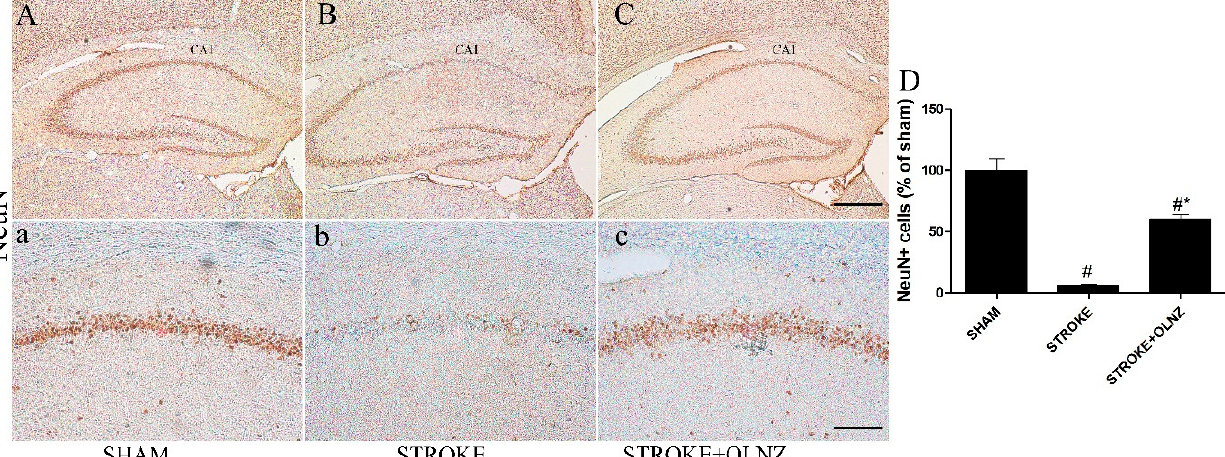
Figure 3. Role of OLNZ in NeuN immunoreactive cells in the CA1 area of the hippocampus. Identification of NeuN+ cells in the sham group ( A ) 10 × and ( a ) 200 × , TI-mediated ischemic stroke group ( B ) 10 × and ( b ) 200 × , and TI-mediated ischemic stroke + OLNZ (10 mg/kg) group ( C ) 10 × and ( c ) 200 × . A small quantity of NeuN immunoreactive cells was superficially noticeable in the TI-mediated stroke animals in comparison with the OLNZ-treated animals. ( D ) The graph signifies the relative numbers of immunoreactive NeuN+ cells. Data were expressed as the mean ± SEM, n = 5 in each group. After performing one-way ANOVA with Tukey’s post hoc tests, p < 0.05 for comparisons of the treatment groups with the sham group (#) and p < 0.05 for comparisons with the TI-induced stroke group (*) were considered significant.